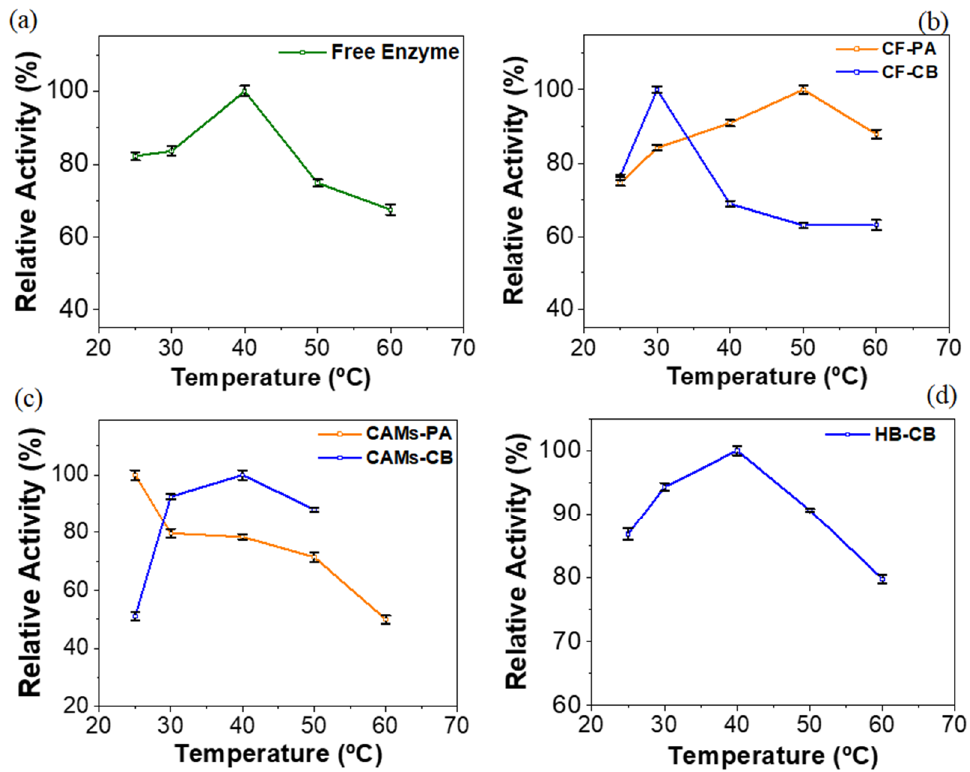
Figure 4. Effect of temperature (25–60 °C) on the radish peroxidase activity. ( a ) Free enzyme. 173 Figure 4. E ff ect of temperature (25–60 ◦ C) on the radish peroxidase activity. ( a ) Free enzyme. Immobilized biocatalysts by physical Adsorption (PA) and covalent Binding (CB) techniques: ( b ) 174 ImmobilizedbiocatalystsbyphysicalAdsorption(PA)andcovalentBinding(CB)techniques: ( b )coconut fiber (CF), ( c ) calcium alginate microspheres (CAMs) and ( d ) SBA-15 / albumin hybrid coconut fiber (CF), ( c ) calcium alginate microspheres (CAMs) and ( d ) SBA-15/albumin hybrid (HB). 175